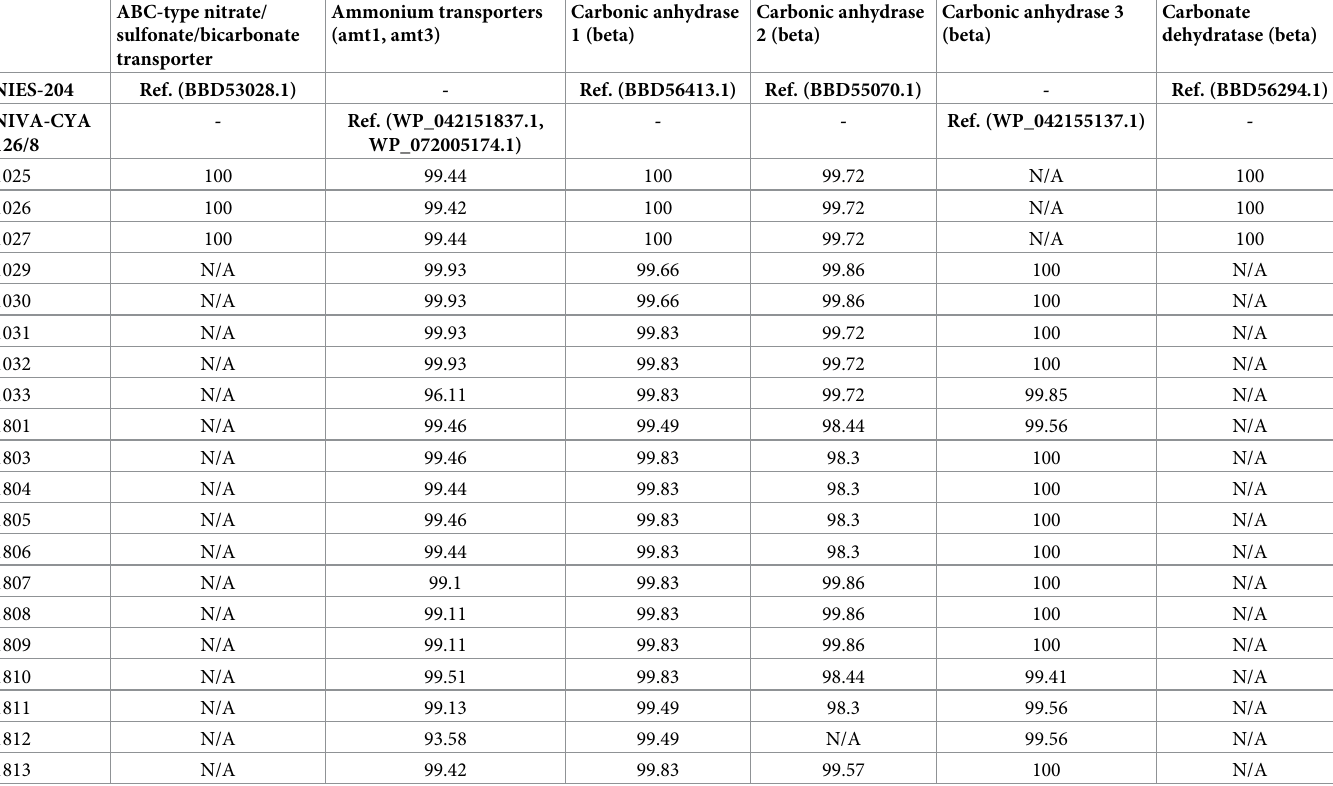
Table 5. Sequence similarity of important nutrient acquisition genes for Planktothrix agardhii . Ammonium transporter genes are linked in the genome and were ana- lyzed as a gene set. ABC-type nitrate/